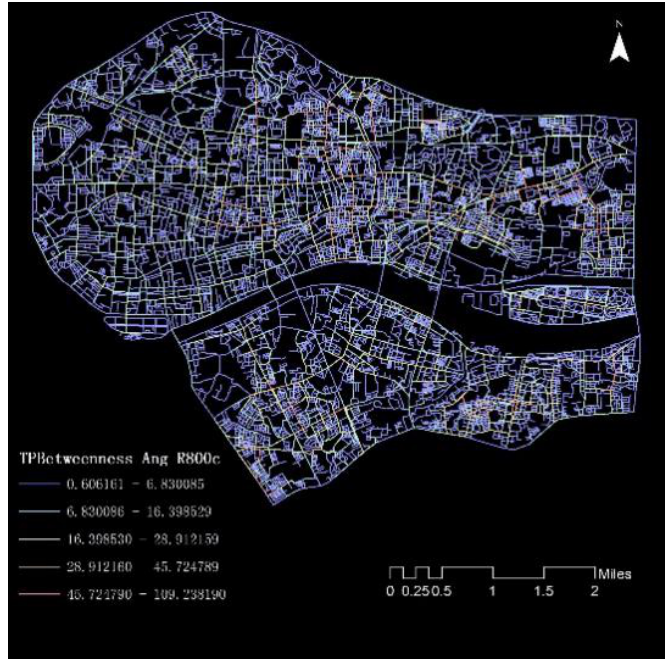
Fig. 17 Regional TPBt at a radius of 1500m